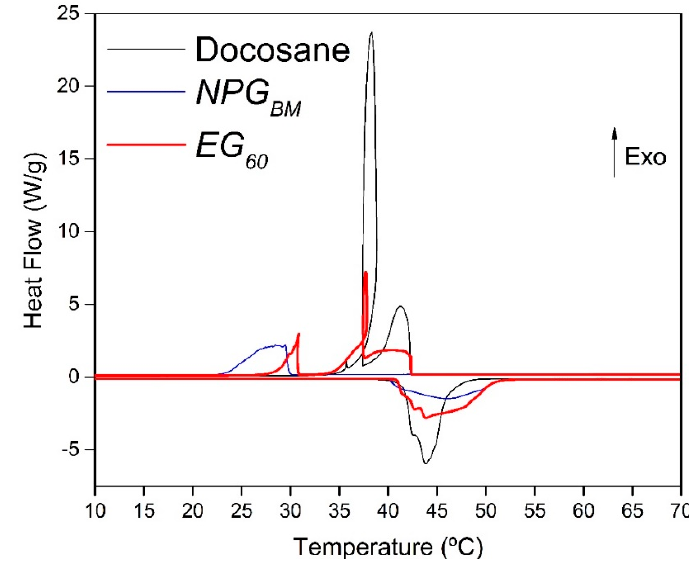
Figure 9. DSC thermogram (heat flux vs. temperature) obtained for NPG, Docosane and EG60. Negative heat flux values correspond to endothermic phenomena whereas positive values represent exothermic phenomena.